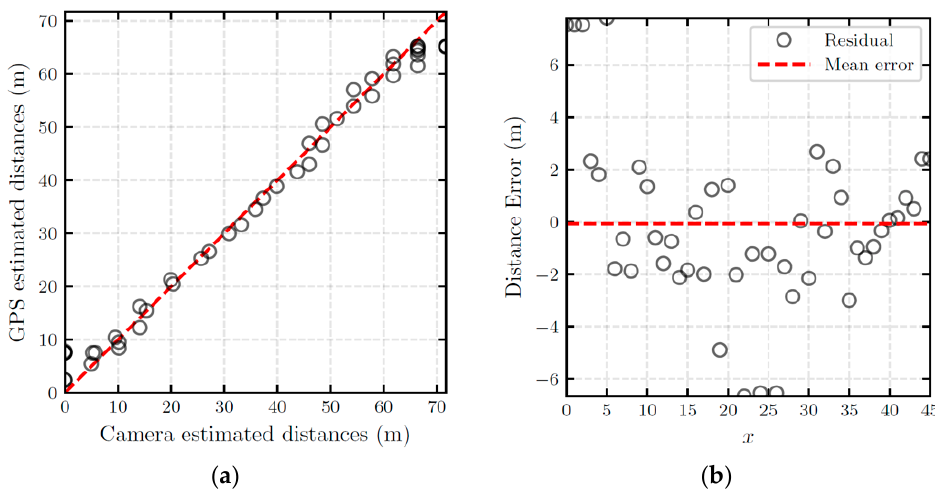
Figure 7. Quantification of pinhole camera-based distance estimation error: ( a ) scatter plot of GPS- and camera-estimated distances; ( b ) plot of the estimation residuals.